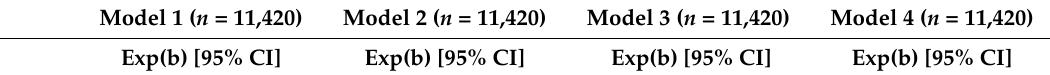
Table 3. Weighted Logistic Regression to Estimates the Association Between Depression and PIR in US Women Aged 20 and above, NHANES